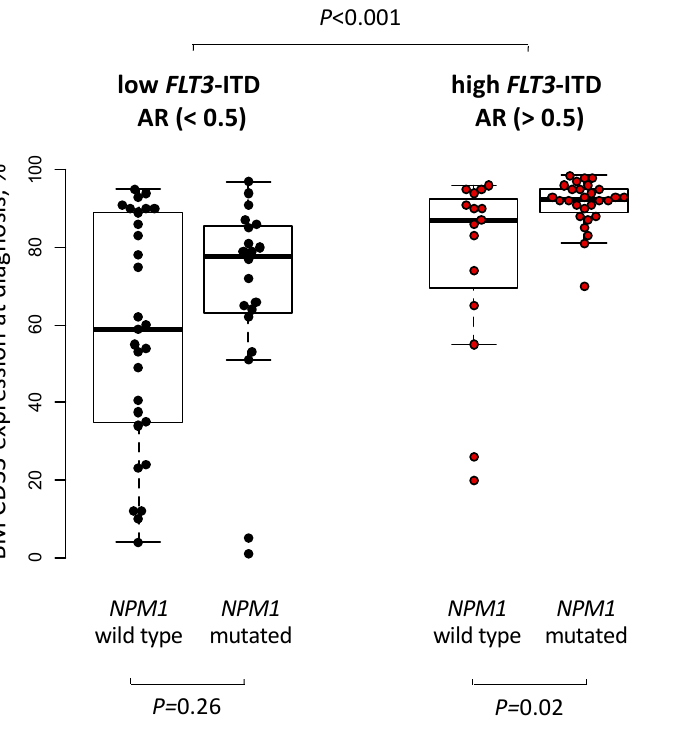
Figure 1. Bone Marrow CD33 expression levels in the context of FLT3 -ITD allelic ratio (AR) as well as NPM1 mutation status.